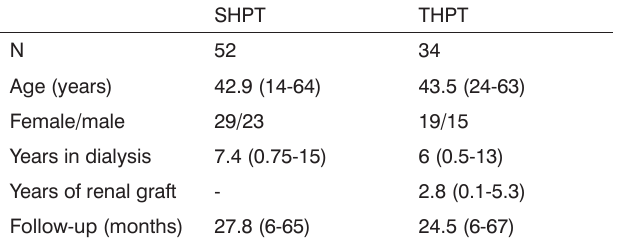
Table 1. Patient demographic